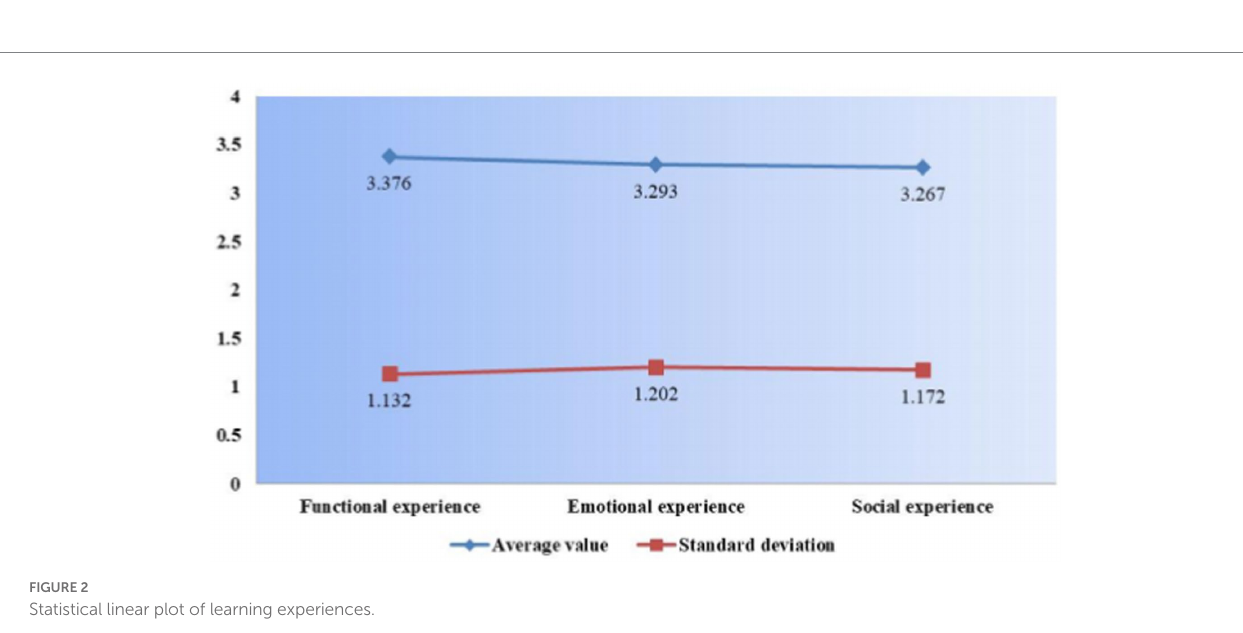
FIGURE 2 Statistical linear plot of learning experiences.